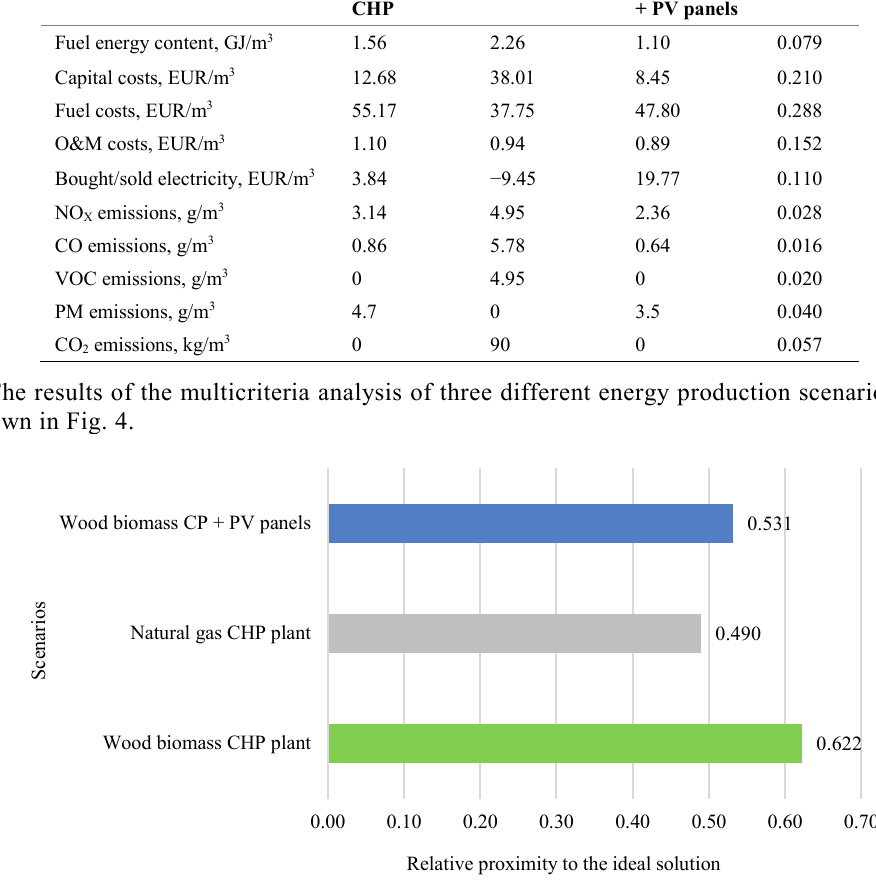
Fig. 4. Multicriteria analysis